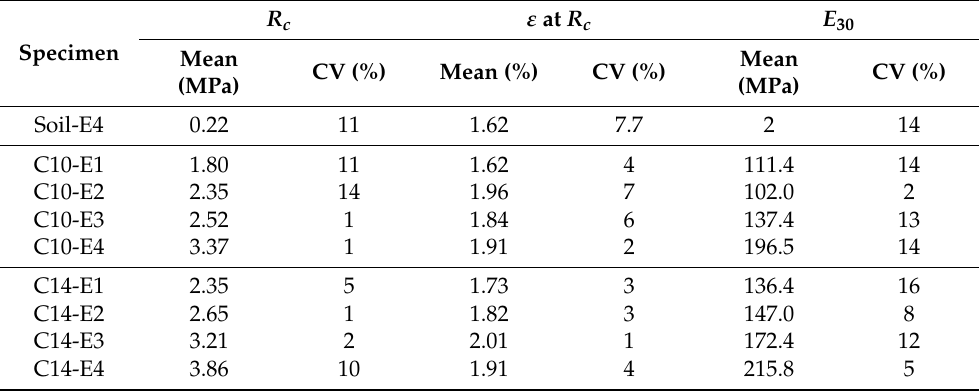
Figure 8. UCT stress–strain curves for CBS specimens with 14% cement. The modulus of elasticity ( E 30 ) was obtained from the stress–strain curves according to [38], with E 30 being the secant modulus for the stress range from 0% to 30% of R c . The values of E 30 , R c and axial strain at R c value are summarized in Table 5 for the soil (E4) and the CBS mixtures. Table 5. Results of unconfined compression tests.